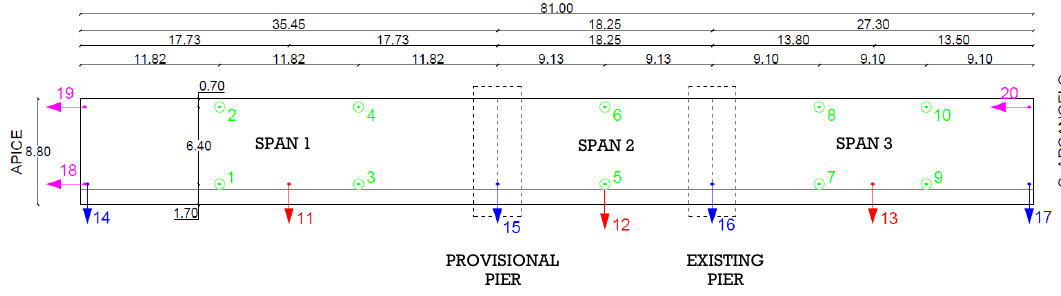
Figure 4. Ufita bridge plain view: sensor layout (length in m).